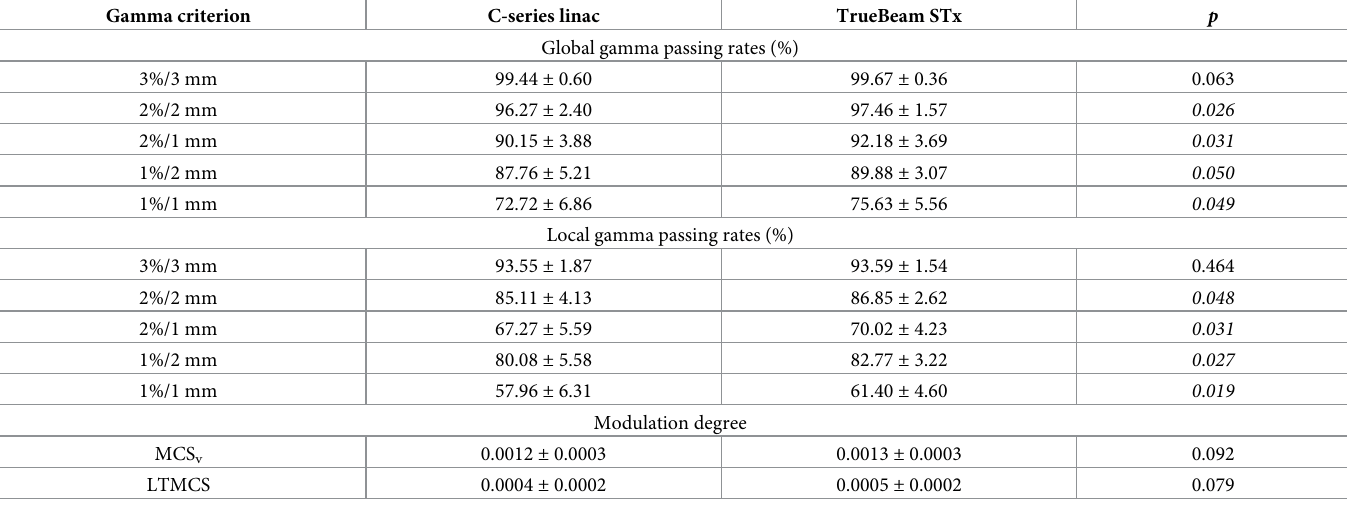
Table 1. Global and local gamma passing rates with various gamma criteria and modulation degrees of the head and neck VMAT plans with the C-series linac and the TrueBeam STx. Gamma